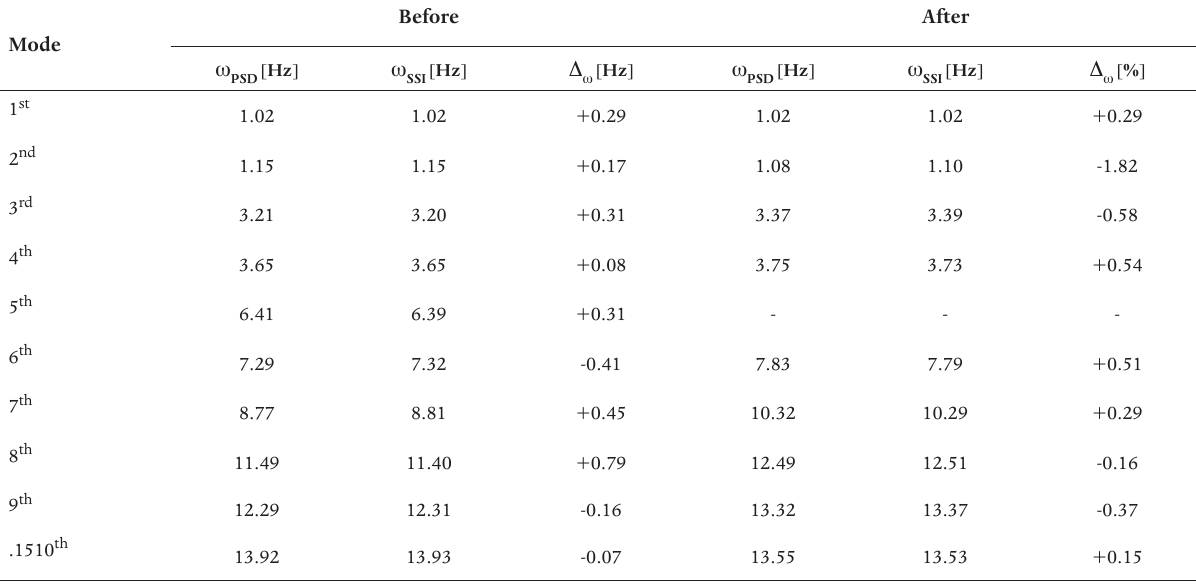
Table 5. Spectral modes vs experimental modes: eigenfrequencies comparison.